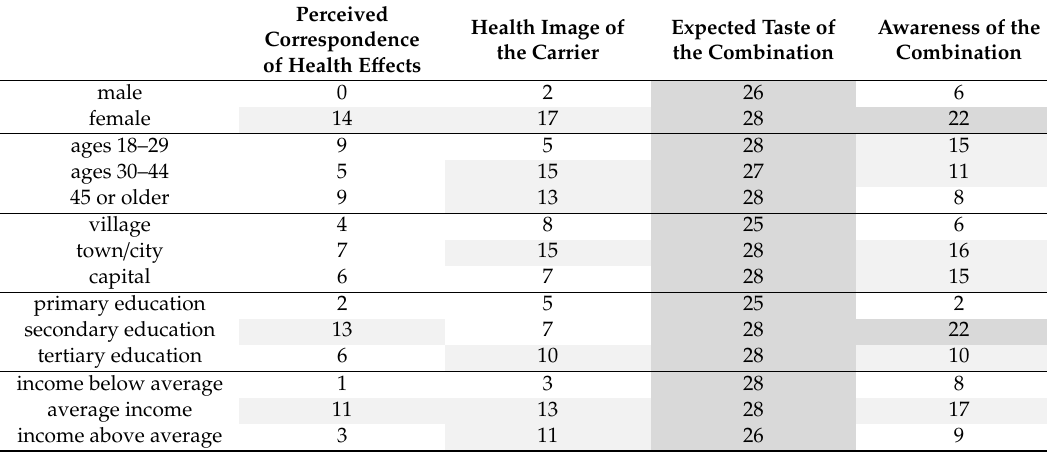
Table 4. The number of functional food combinations (out of 28) where perception of carrier / ingredient fit was significantly a ff ected by predictors within di ff erent demographic groups.